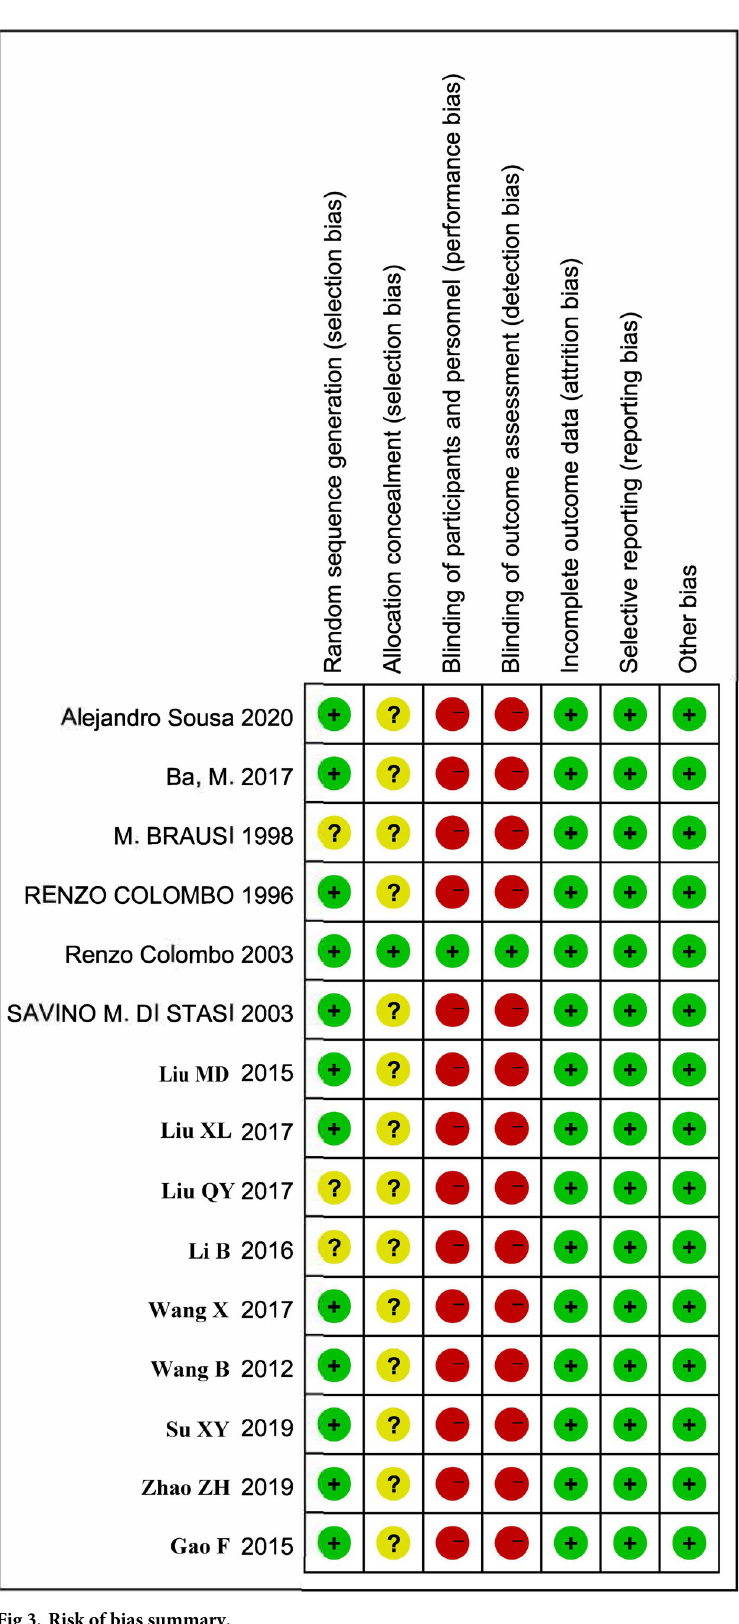
Fig 3. Risk of bias